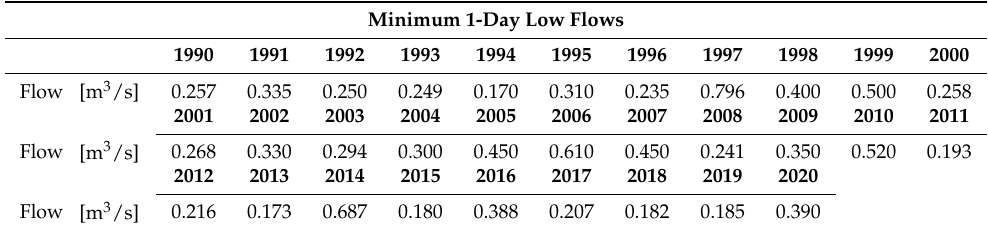
Table 3. The observed data from Prigor hydrometric station.